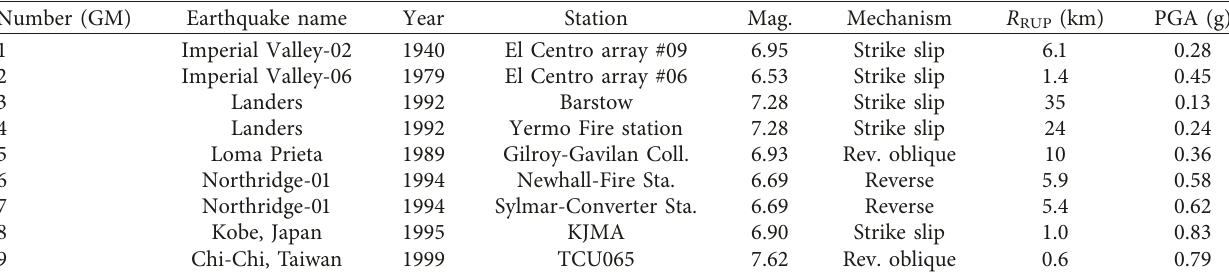
Figure 4: Modified acceleration-displacement response spectrum (MADRS). Table 1: Unscaled ground motions recorded during several